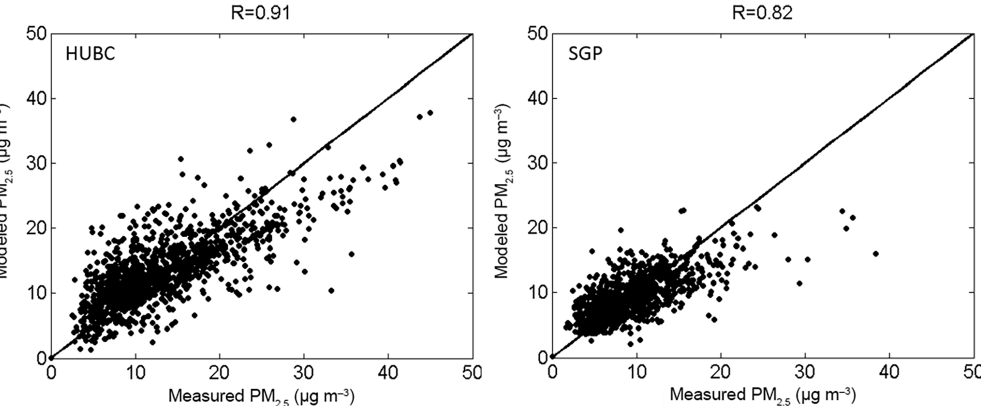
Figure 12. Comparison of daily average PM2.5 between in situ measurements and model simulation at the HUBC site and ARM SGP